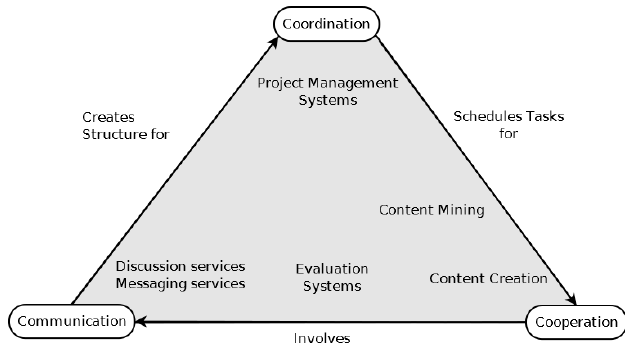
Figure 1. Iteration cycle of collaborative work based on the 3C model as stated by Fuks et al. [11] and required services for each step as stated by